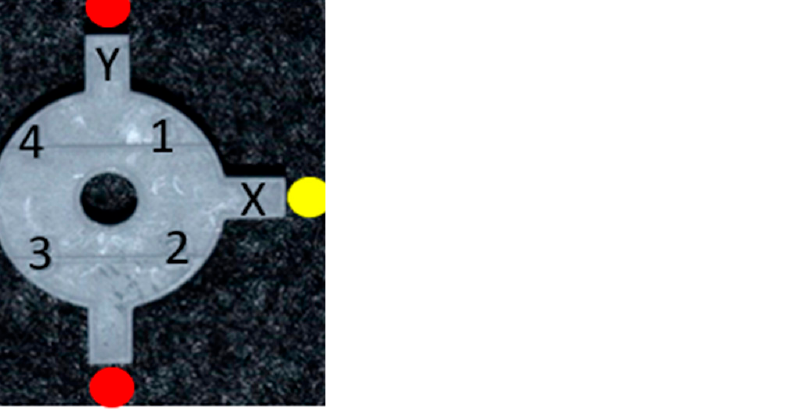
Figure 8. Picture denoting the orientation of digital caliper jaws for measurement. The red dots show the orientation of the lower jaws of the calipers to measure along the Y ‐ axis. The yellow dots show the orientation of the lower jaws of the calipers to measure along the X ‐ axis.